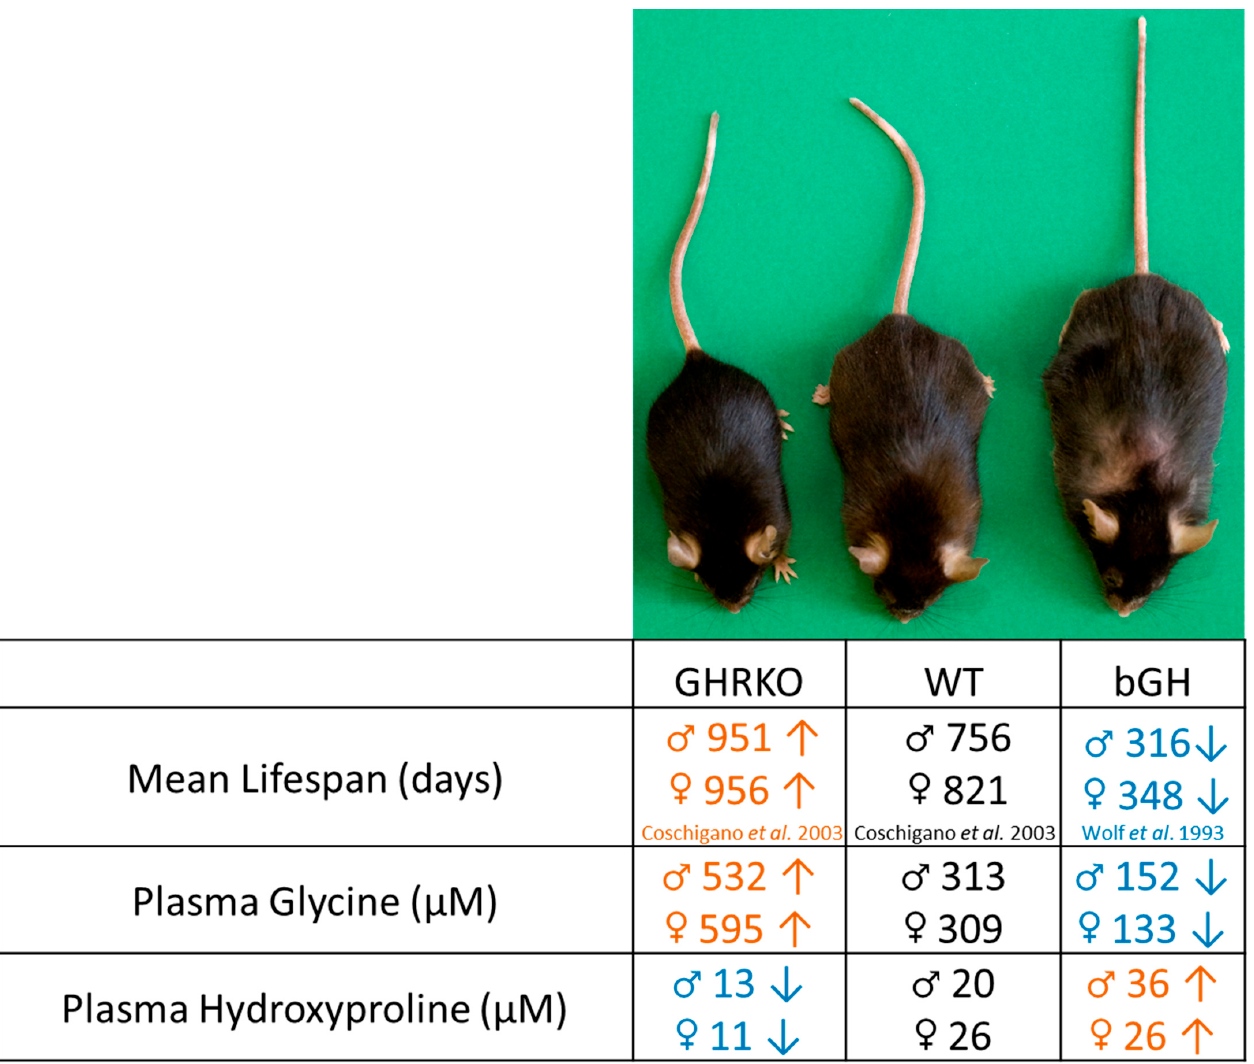
Figure 4. Association between plasma amino acid levels and lifespan. This image depicts the two primary mouse models examined in this study. The table shows the average lifespan of each mouse model, as reported previously [9,11], compared to the plasma levels of amino acids reported in this study. Arrows indicate p < 0.05 compared to WT. The WT lifespan is from the control group of the GHRKO study, as that study utilized the same genetic background (C57Bl/6J) as this experiment. In conclusion, excess GH increases while GH resistance decreases plasma glycine levels, and these alterations may be due to the modulation of glycine synthesis and not